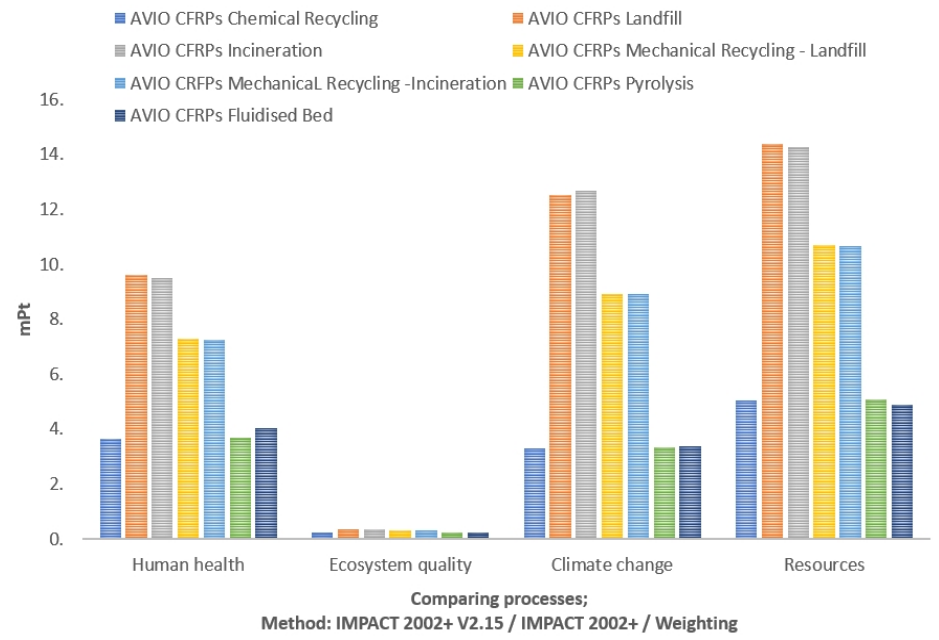
Figure 23. Results of overall comparison of recycling routes into endpoint categories.